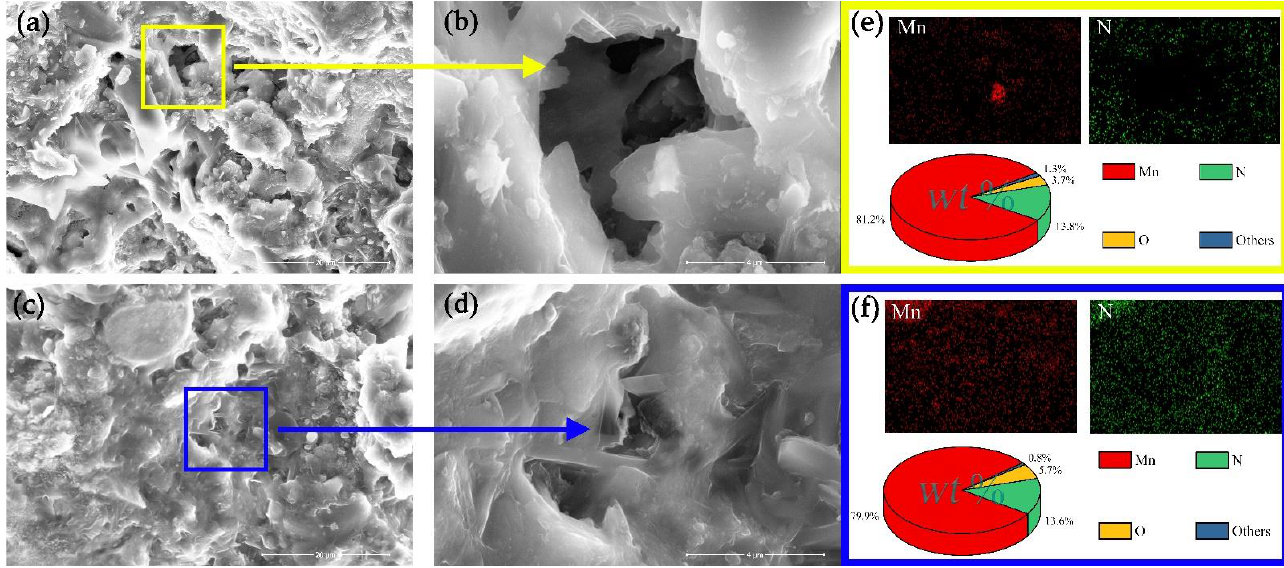
Figure 2. ( a – d ) show the low- and high-magnification SEM images of Mn 3 N 2 bulk materials. ( a , b ) are the samples after primary synthesis, and ( c , d ) are the samples after secondary sintering. ( b ) is the magnification area of the yellow box in ( a ); ( d ) is the magnification area of the blue box in ( c ). ( e ) Element distribution diagram and element content diagram of yellow box of initial synthesis by EDS; ( f ) element distribution diagram and element content diagram of blue box of initial synthesis by EDS.